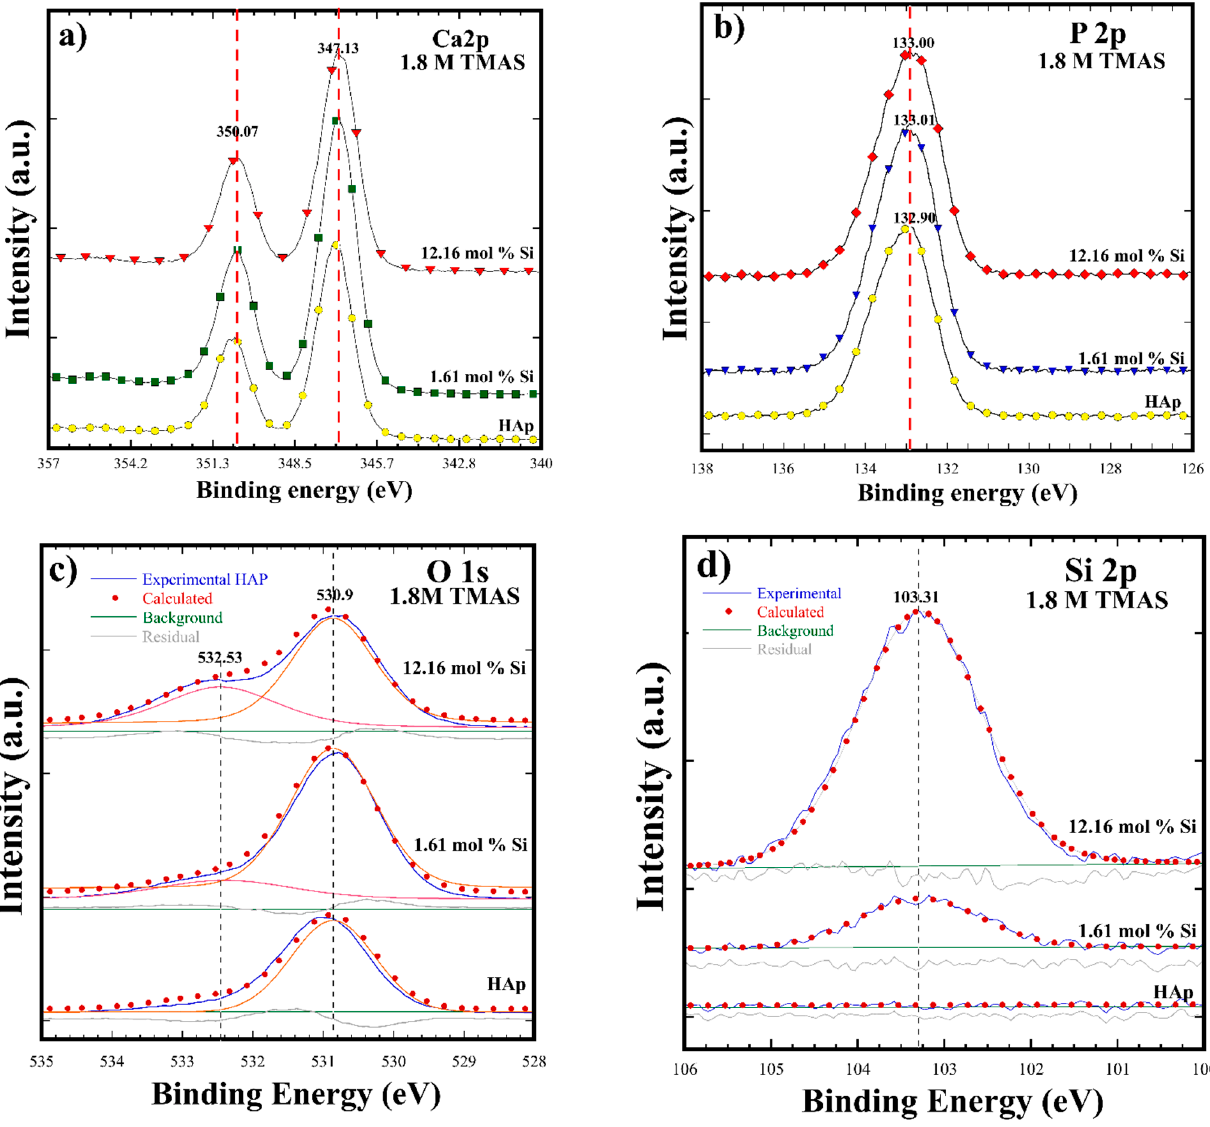
Figure 5. The XPS analysis for HAp and Si-HAp powders obtained by microwave assisted hydrothermal process at 150 °C for 1 h using 0.9 M of TMAS and different mol% of Si: ( a ) Ca 2p; ( b ) P 2p; ( c ) O 1s; ( d ) Si 2p.